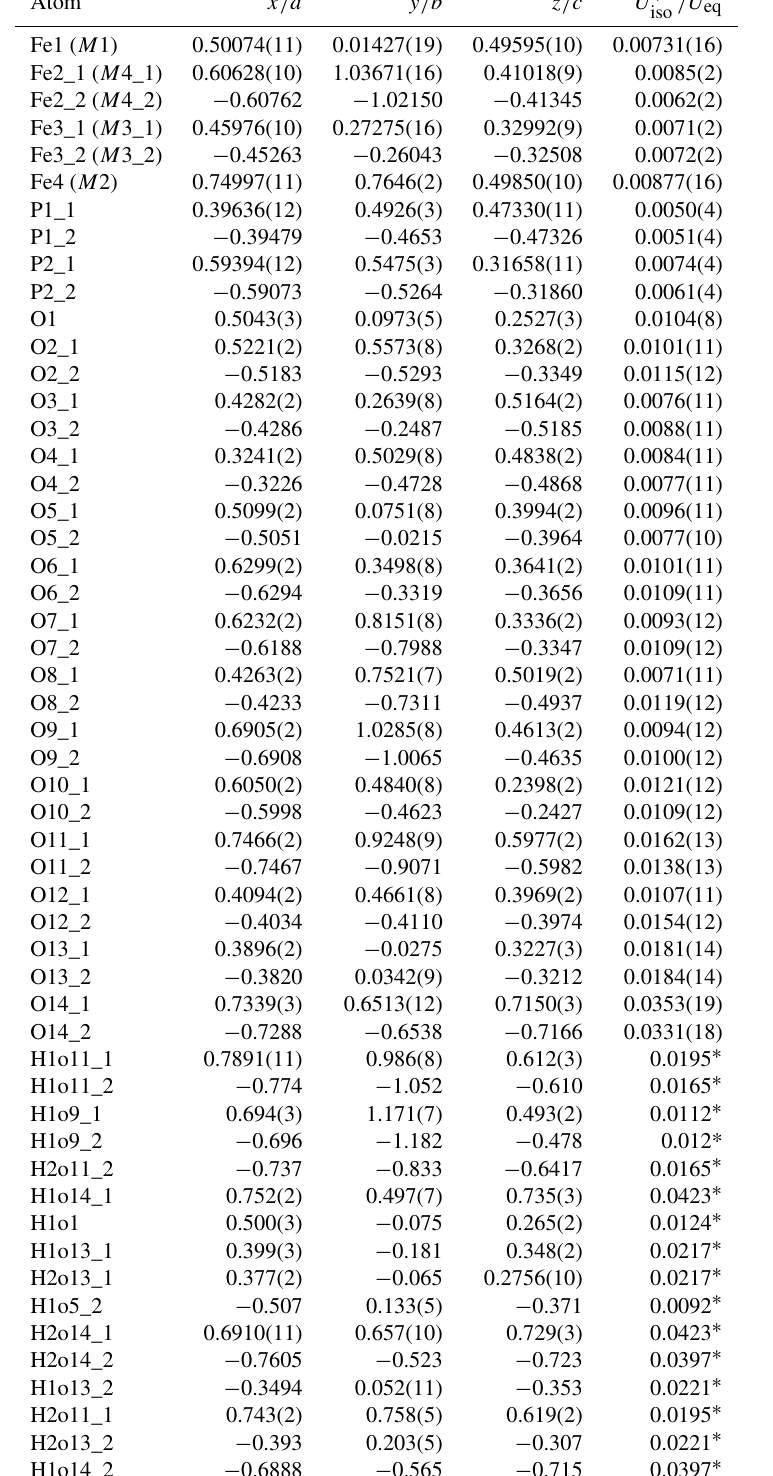
Table 6. Atom coordinates and displacement parameters (as isotropic or equivalent; Å 2 ) for the structure of